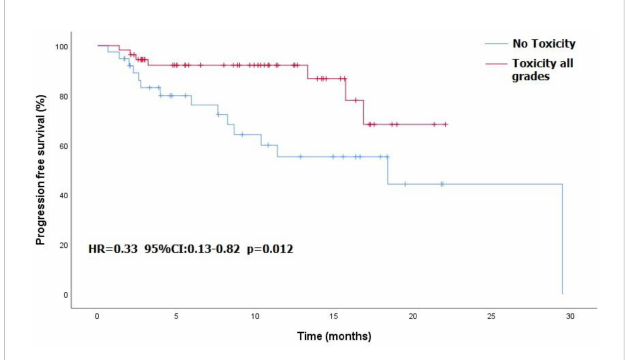
FIGURE 1 Progression-free survival in patients with and without